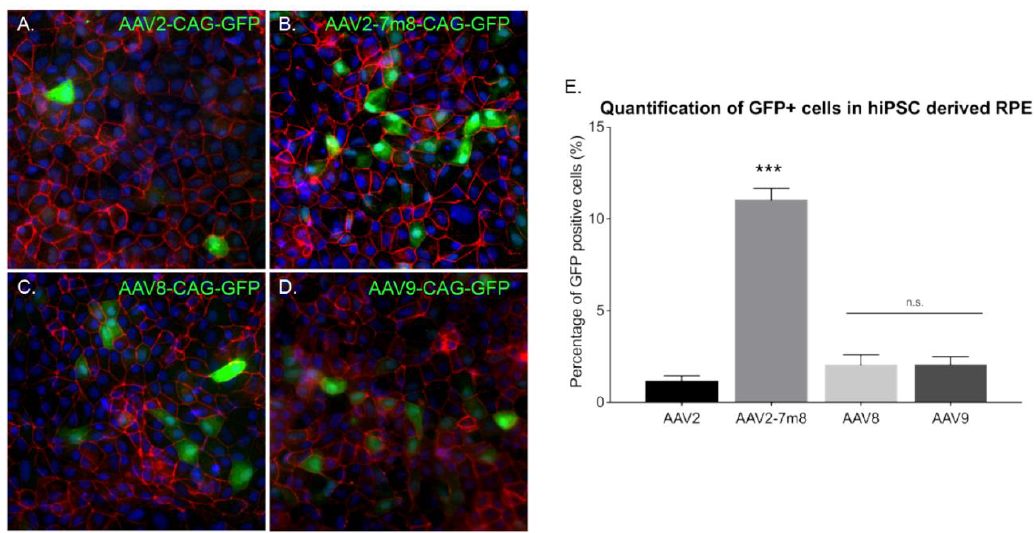
Figure 6. AAV mediated gene delivery to hiPSC derived RPE. ( A–D ) Epifluorescence images of the expression of the RPE structural marker ZO1 (red), the reporter protein GFP (green), and the nucleus marker DAPI (blue) in hiPSC-derived RPE cultures infected with di ff erent AAVs. Scale bar: 50 µ m ( A ) AAV2-CAG-GFP, ( B ) AAV2-7m8-CAG-GFP, ( C ) AAV8-CAG-GFP, ( D ) AAV9-CAG-GFP. ( E ) Percentage (%) of GFP positive cells in hiPSC-derived RPE cultures infected with di ff erent capsids quantified using ImageJ analysis. N = 3. Values are mean ± SEM. For statistical significance Mann–Whitney